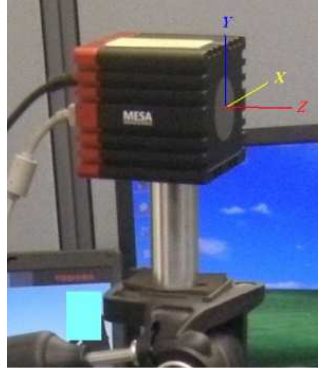
Figure 1. SR4000 camera (Altuntas, 2014)